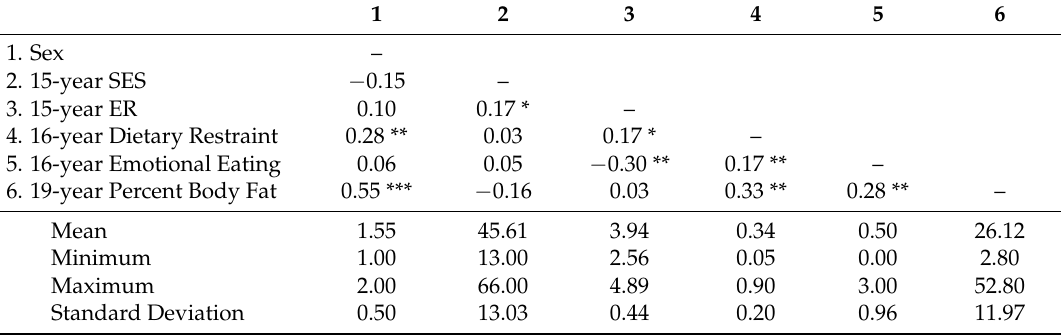
Table 1. Characteristics of the Adolescent Sample and Correlations among Model